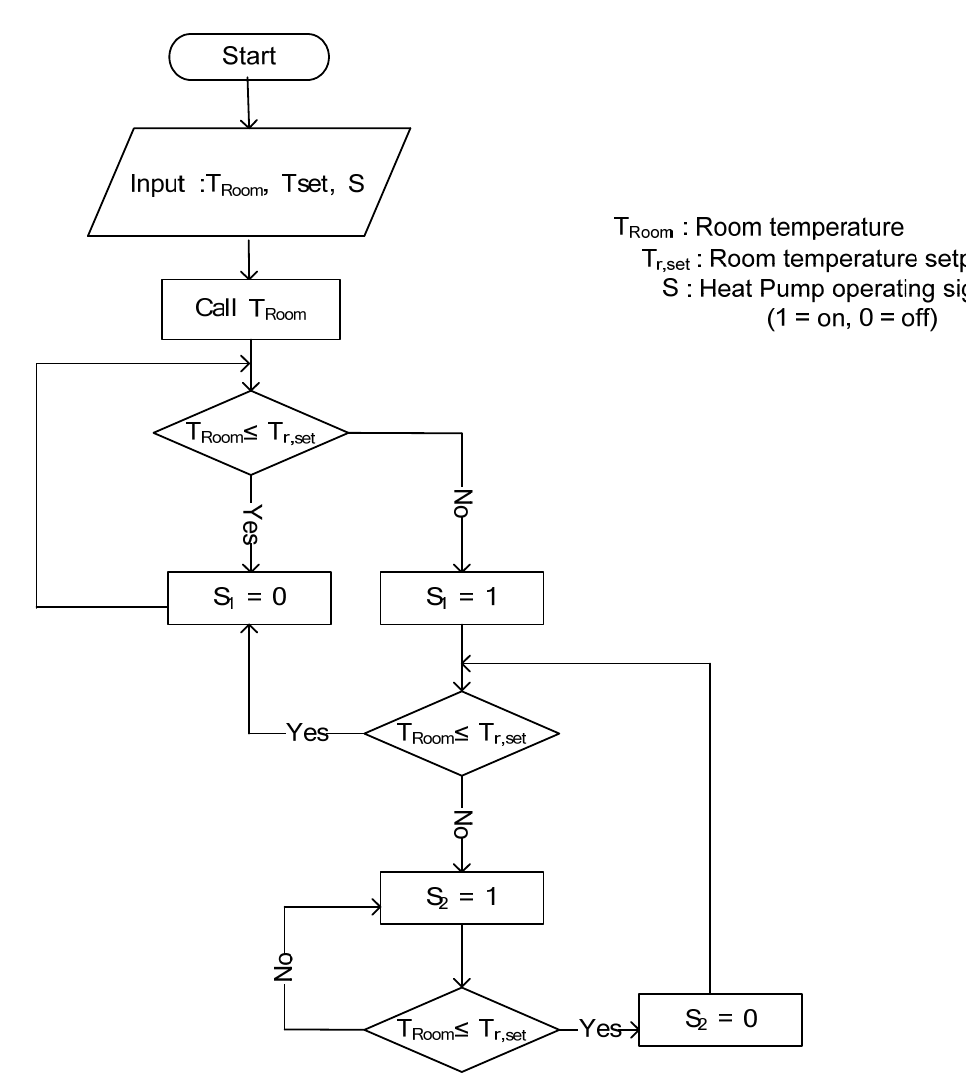
Figure 6. Control algorithms of the sequencing operation condition of the Multi-GHP system. 3.2. Combination with Multi-Geothermal Heat Pump ( Multi-GHP) System and an Absorption (ABS)